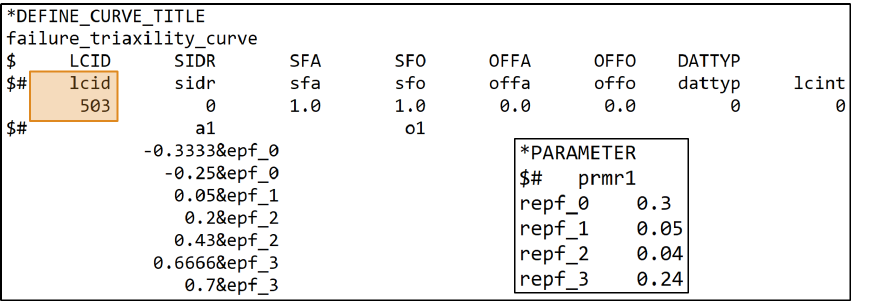
Figure A3. Equivalent plastic strain at failure vs. triaxiality curve for MAT_ADD_DAMAGE_GISSMO , with (r)epsf_0 to (r)epsf_3 (equivalent plastic strain at failure) being parameters which need to be